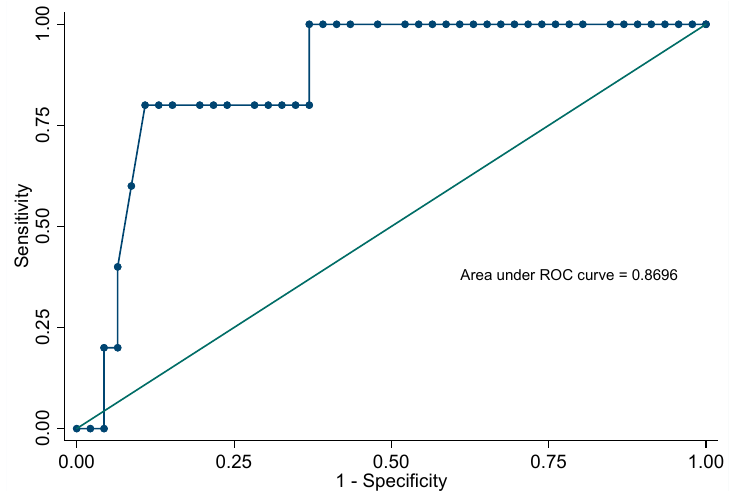
Figure 2. Receiver operating characteristic curve for Ct values to differentiate colonization and real infection.